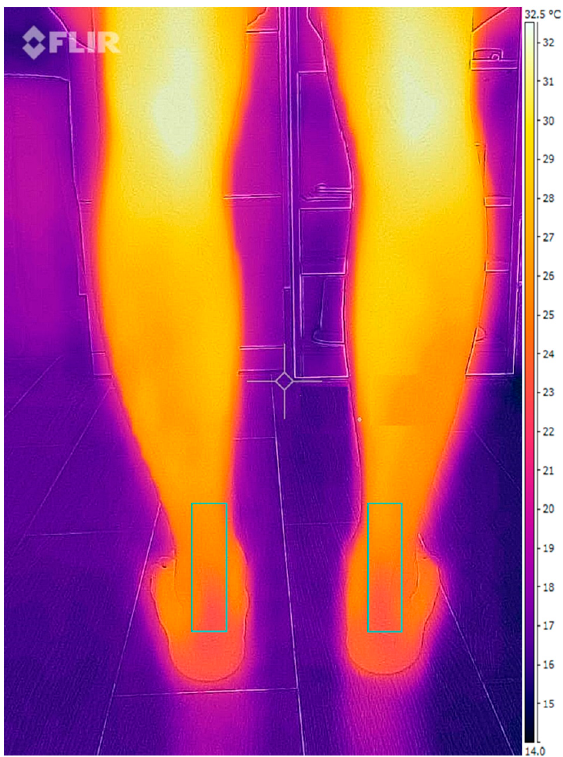
Figure 1. Achilles tendon infrared (IR) imaging.